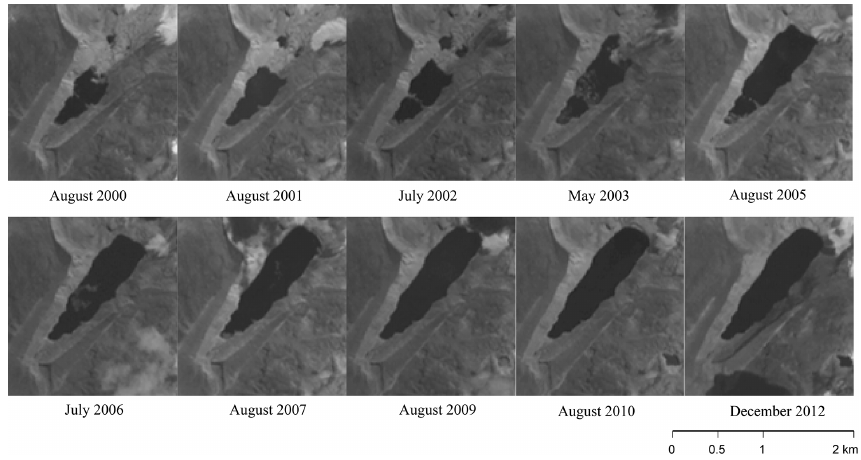
Figure 4. Growth pattern of Lake Palcacocha from 2000 to 2012: a sequence of ASTER satellite images reveal that the lake growth is following the glacier-retreat direction, changing the morphology of the lake’s bottom (ASTER data from NASA Land Processes Distributed Active Archive